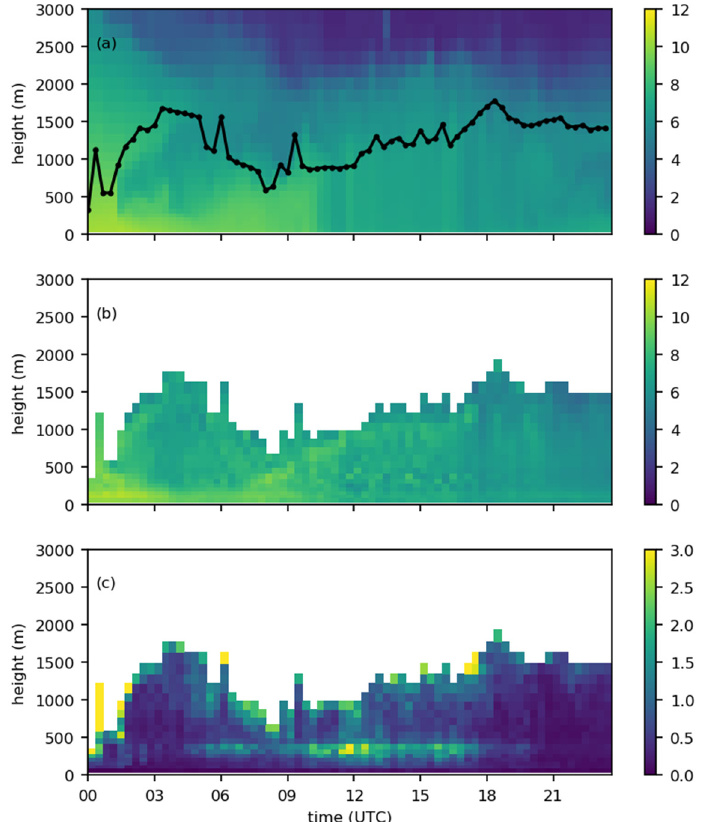
Figure 13. Example mixing ratio time-series for 14 July 2020: ( a ) UKV model background; ( b ) BB- DIAL estimation thinned at UKV temporal and vertical resolution; ( c ) BB-DIAL uncertainty, all values are g/kg